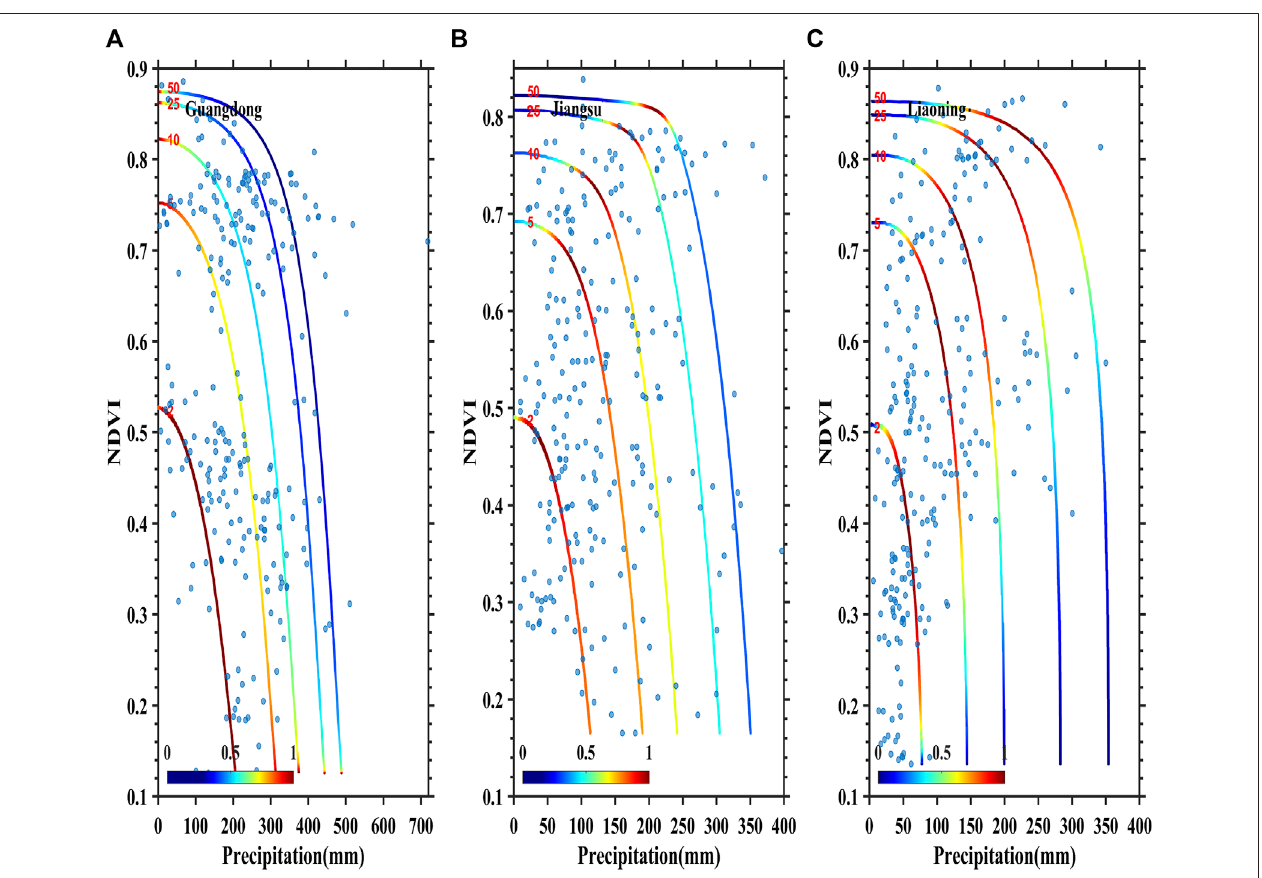
FIGURE 10 | Survival copula return periods of precipitation-normalized difference vegetation index (NDVI) in (A) Guangdong, (B) Jiangsu, and (C) Liaoning.